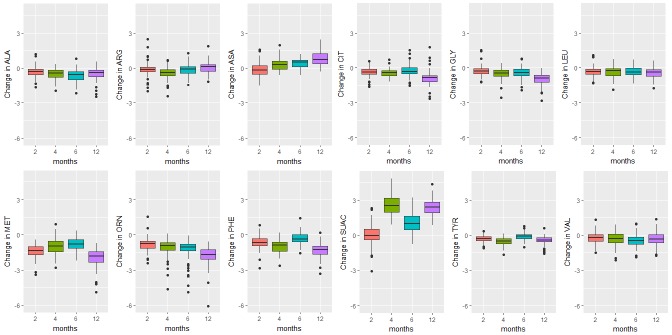
Amino acids.Boxplots of the change in analyte levels after 2-, 4-, 6-, and 12-months of storage from baseline. The most variable marker in this category was argininosuccinic acid (SUAC). The lower whisker = smallest observation greater than or equal to lower hinge - 1.5 * IQR, and the upper whisker = largest observation less than or equal to upper hinge + 1.5 * IQR.